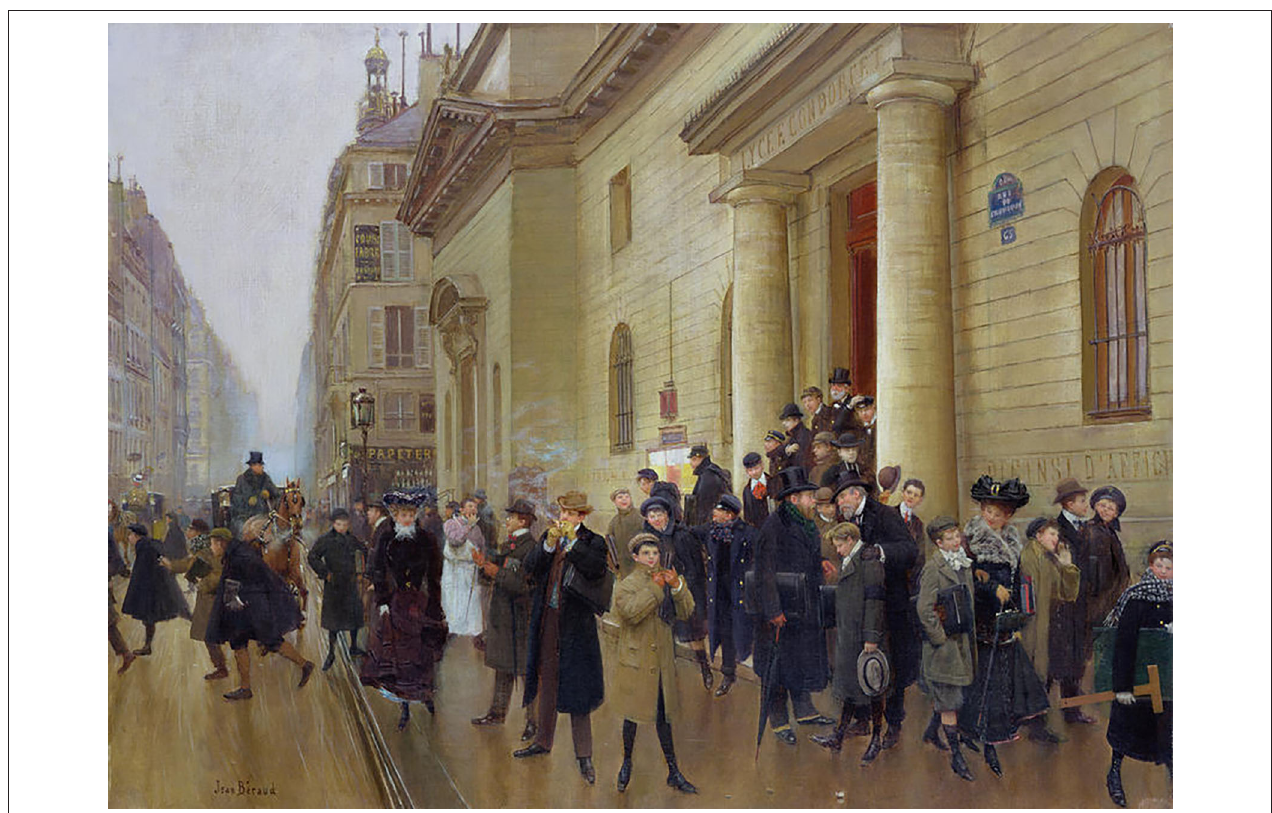
FIGURE 2 | La sortie du lycée Condorcet, jean Béraud, 1903, Musée Carnavalet,